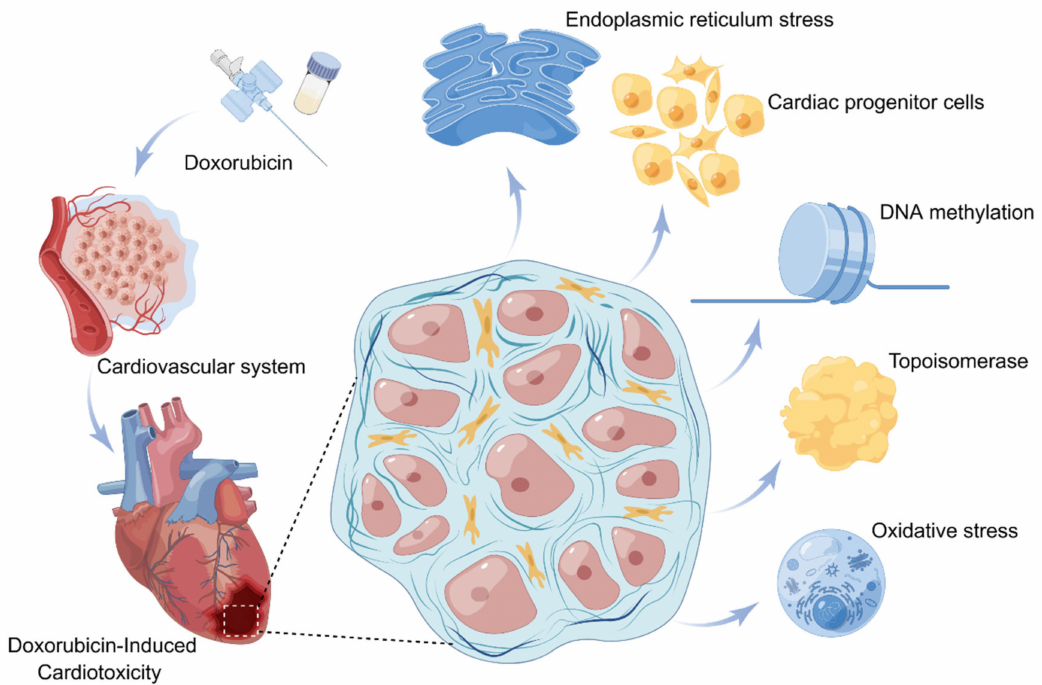
Figure 2. Mechanism diagram of DIC. Five potential mechanisms by which DOX acts on the cardio- vascular system and produces cardiotoxicity: oxidative stress; the role of topoisomerase in DIC; DNA methylation; cardiac progenitor cells; endoplasmic reticulum